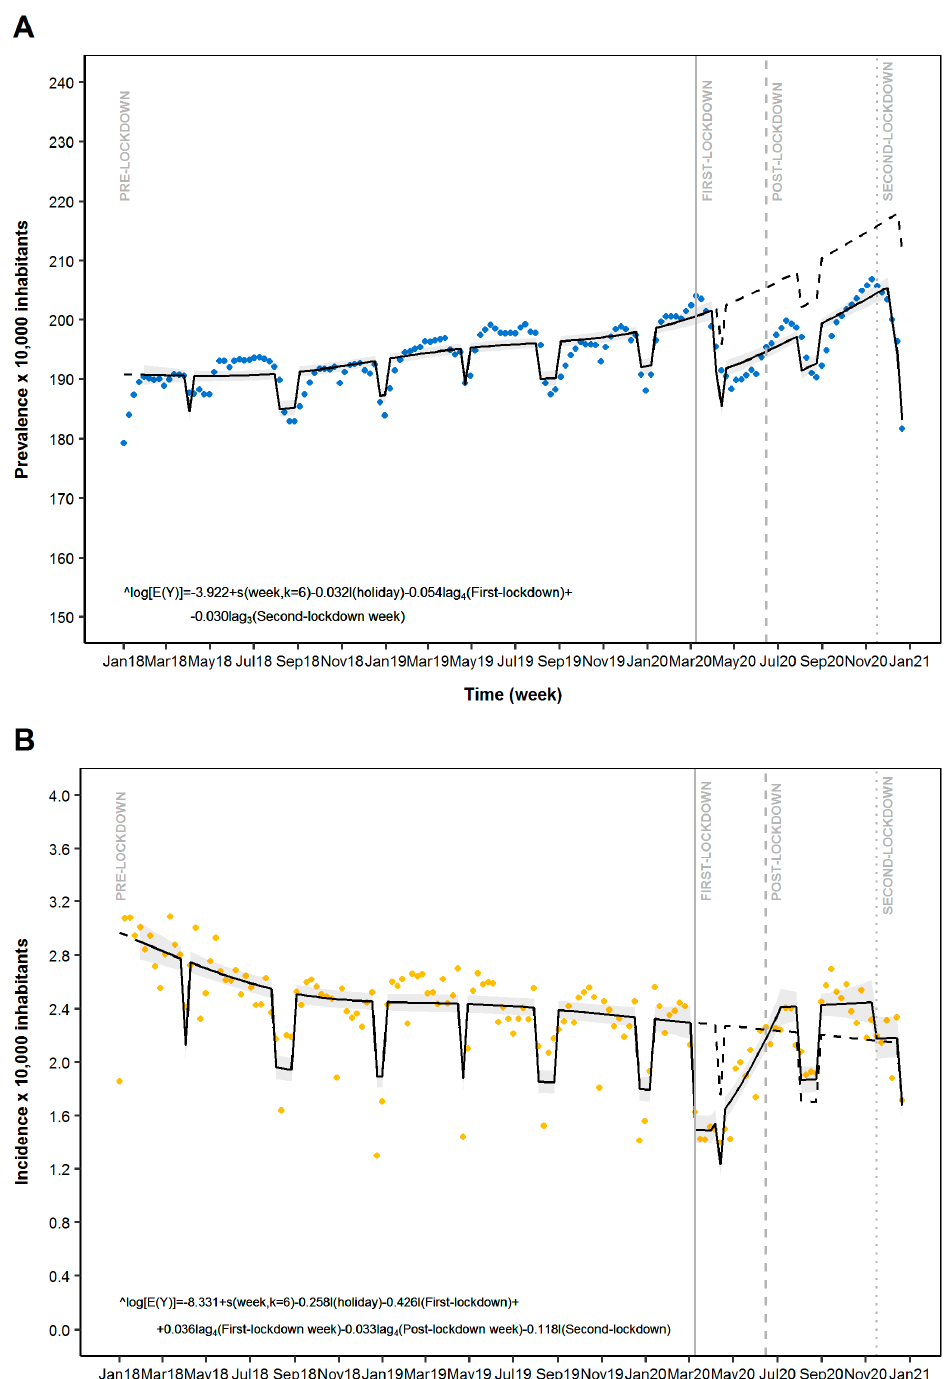
Figure 1. Time series analysis of anti-seizure medication (ASM) use across different periods: Pre-Lockdown, First Lockdown, Post-Lockdown and Second Lockdown. Legend: Panel ( A ) Prevalence of ASM use; Panel ( B ) Incidence of ASM use. Blue dots: estimated prevalence of ASM use; Orange dots: estimated incidence of ASM use; solid line: predicted model based on estimated outcome; Grey zone: 95%CI of the predicted model; Dashed line: expected scenario in the absence of LMI.